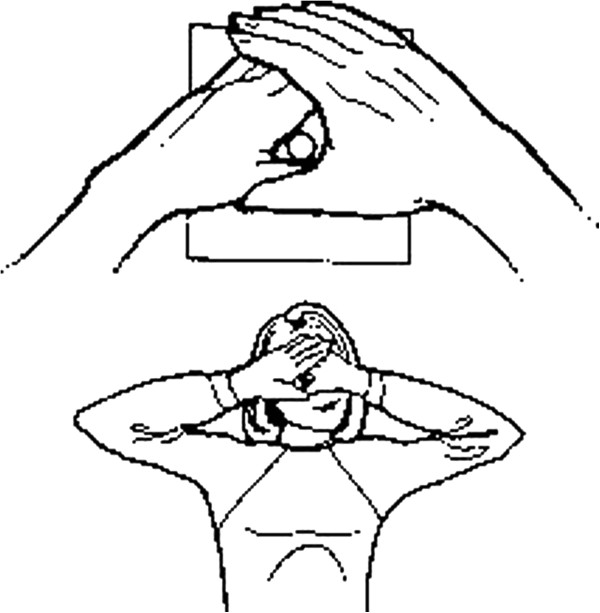
Dominant eye test.